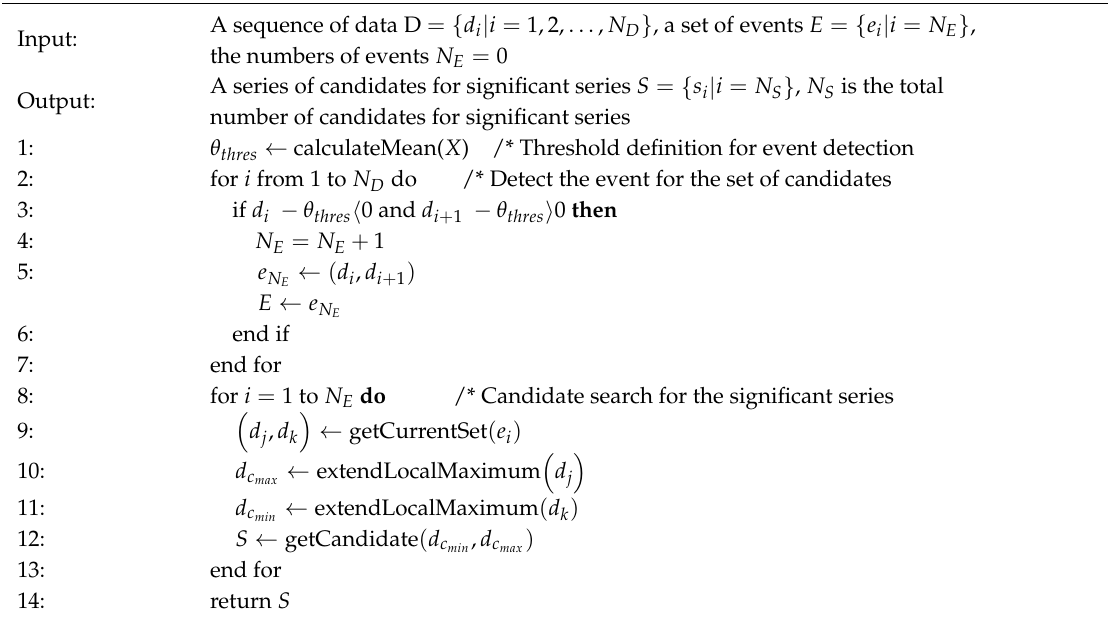
Algorithm 1 : Candidate search algorithm for significant